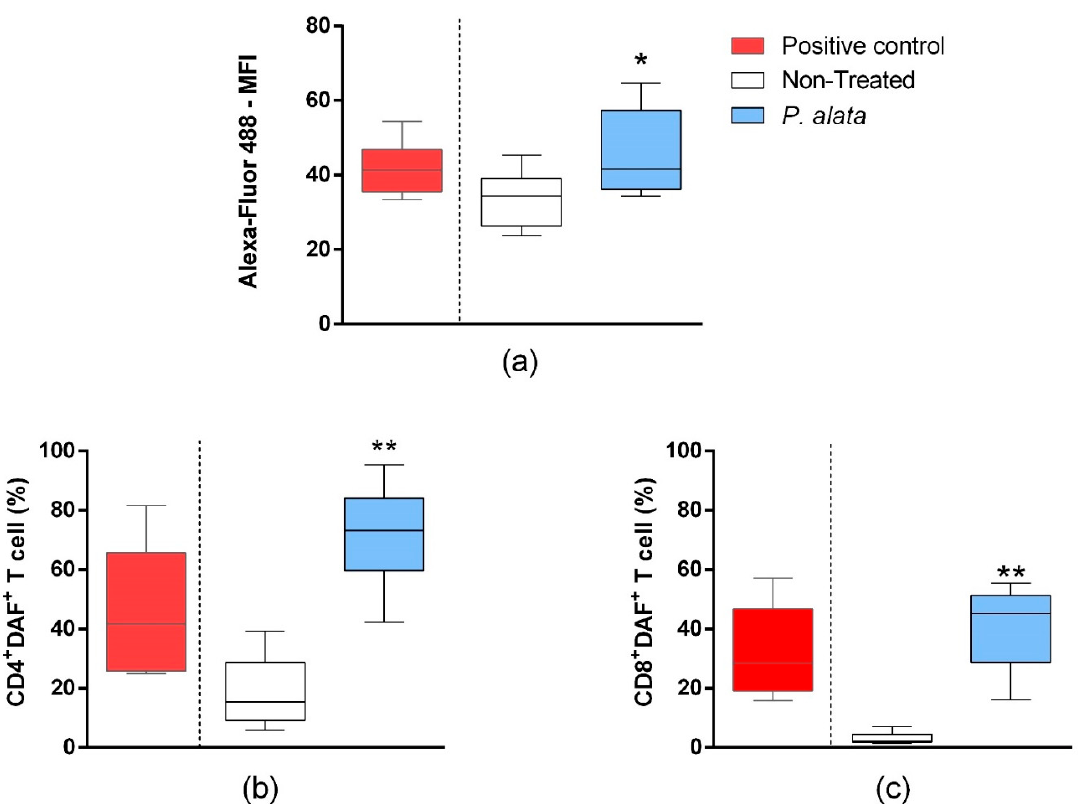
Figure 5. Effect of P. alata extracts on membrane lipid peroxidation and nitrogen reactive species production in T cells co-cultured with pancreatic beta-cell lineage (MIN-6). The boxplots ( a ) represent the median fluorescence intensity (M.F.I) of Alexa Fluor™ 488 fluorescent probe linked to alkyne-modified linoleic acid, which suffered lipid peroxidation using copper-catalyzed click chemistry (Click-iT Lipid peroxidation Imaging Kit—Thermo Scientific) in T cells treated (grey boxplots) or non-treated (white boxplots) with IC 50 doses of P. alata extract. As a positive control of the assay, the culture was stimulated with the oxidizing agent cumene hydroperoxide at a concentration of 600 mM (black boxplots). The boxplots in panels ( b , c ) represent, respectively, the frequency (%) of CD4 + and CD8 + T cells presenting the 4-amino-5-methylamino-2 (cid:48) ,7 (cid:48) -dichlorofluorescein diacetate probe (DAF + ), which specifically detects nitric oxide inside the cells. Thus, as a positive assay control, the culture was submitted to nitric oxide donor sodium nitroprusside (SNP) at 0.2 mM (black): * p < 0.05; ** p < 0.0001; n = 6 with triplicate cell